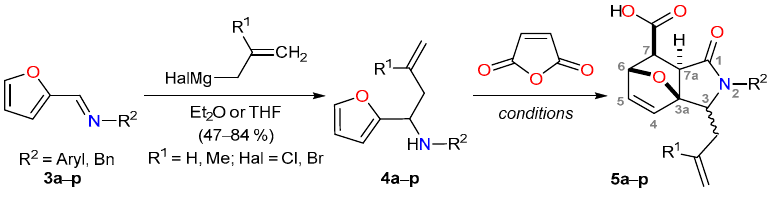
Figure 2. Structures of the cis and trans diastereoisomers of 3a,6-epoxyisoindole-7-carboxylic acids 5.